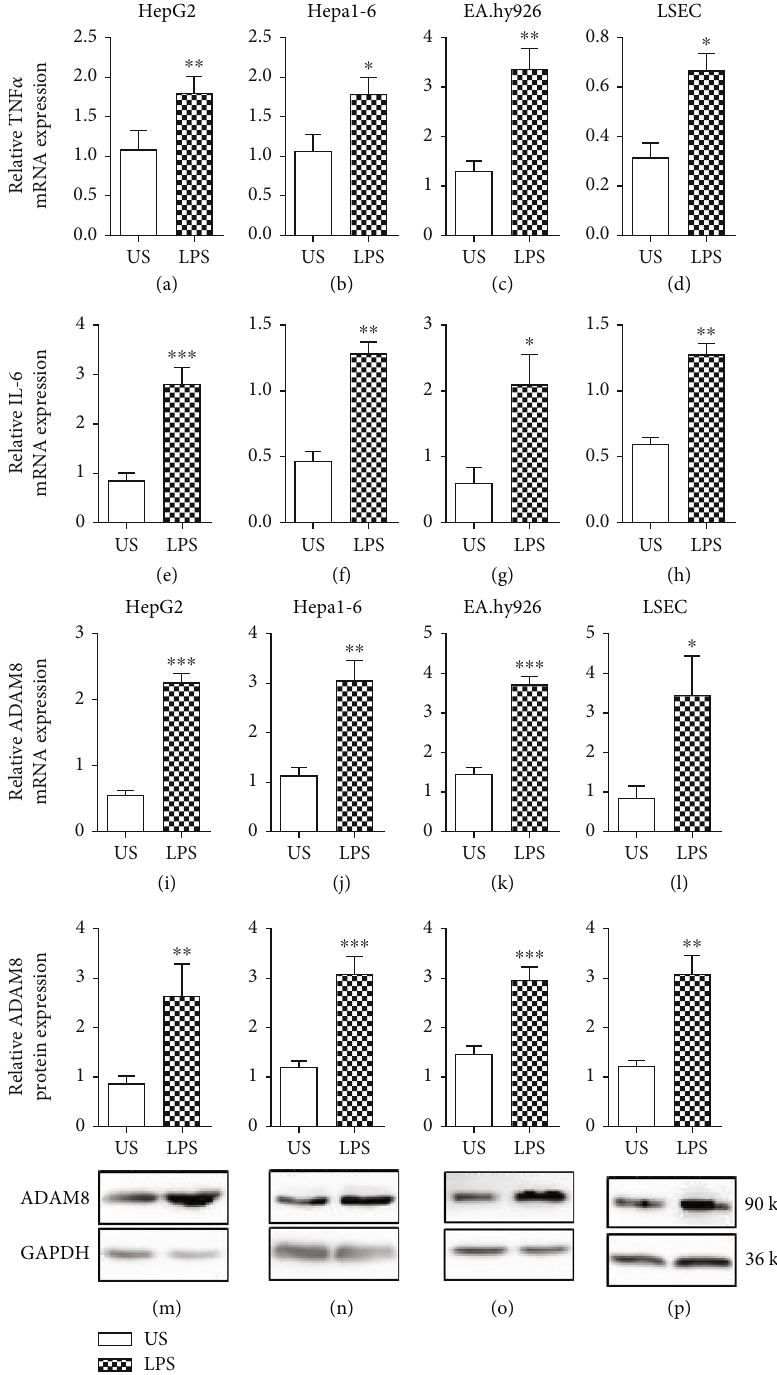
Figure 2: Upregulation of ADAM8 expression in hepatocyte and endothelial cells by LPS. (a – p) Human HepG2 and murine Hepa1-6 hepatoma cells as well as human EA.hy926 and murine LSEC endothelial cells were stimulated with or without LPS (1 μ g/ml). After 24 h of stimulation, cells were analysed for mRNA expression of TNF- α (a – d), IL-6 (e – h), and ADAM8 (i – l). The mRNA expression level was determined by qPCR and normalised to the mRNA expression of GAPDH (for human cells) and Rps29 (for murine cells). Additionally, ADAM8 protein expression was detected by Western blot analysis (m – p). The antibody detects a band of approximately 90kDa, i.e., mature ADAM8. The data are shown as representative blot for each cell line. The band intensities were quanti fi ed by densitometry and normalised to GAPDH protein expression. Quantitative data are shown as the mean + SD of 3-4 independent experiments. Signi fi cant di ff erences to the unstimulated controls are indicated by asterisks ( ∗ p < 0 : 05 , ∗∗ p < 0 : 01 , and ∗∗∗ p < 0 : 001